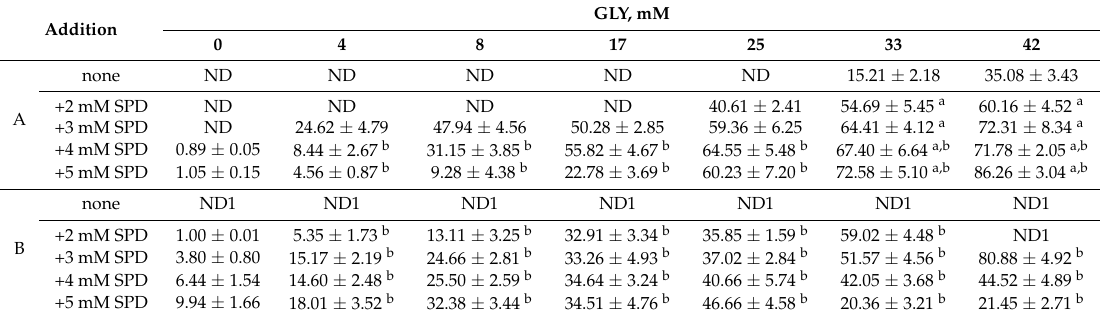
Table 2. Effect of different concentrations of SPD and GLY on the elongation at break (EB, %) of native (A) and heat- denatured (B) BV protein films obtained at pH 8.0